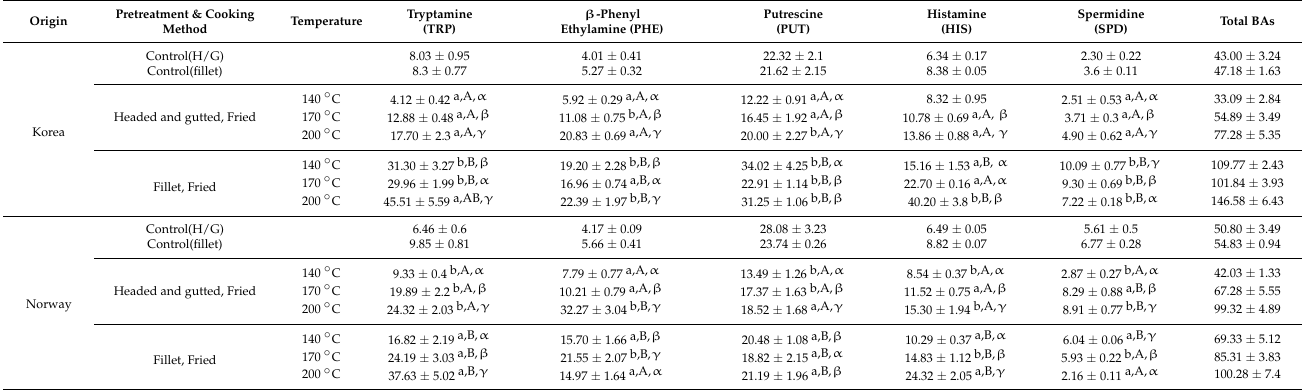
Table 4. Concentrations of BAs in fried mackerel